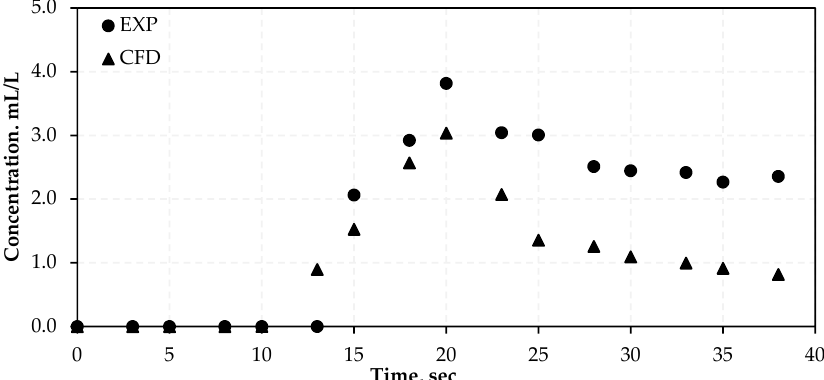
Figure 7. Concentration comparison between experimental (EXP) analysis and CFD modeling at the sampling outlet.